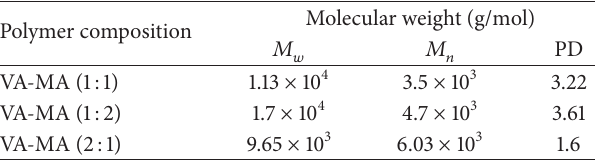
Table 2: The average molecular weight of the prepared copolymer at different mole